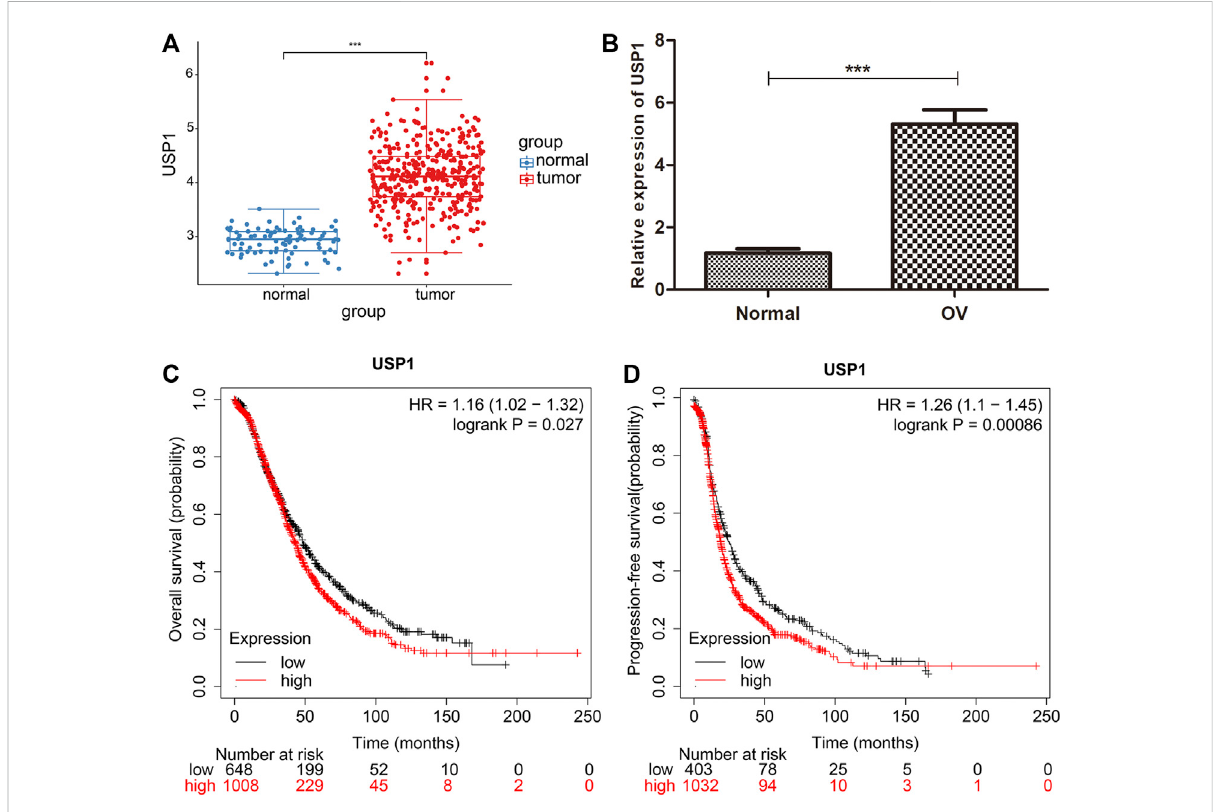
FIGURE 3 USP1ishighly expressedinOVandisassociatedwithpatientprognosis. (A) Expression ofUSP1inOVtissuesfromTCGAdatabase. (B) Real-time PCR analysis to quantify the levels of USP1 in 20 paired OV tissues. (C) Kaplan-Meier survival curves for overall survival of patients with high and low USP1 expression. (D) Kaplan-Meier plots of progression-free survival in patients with high and low USP1